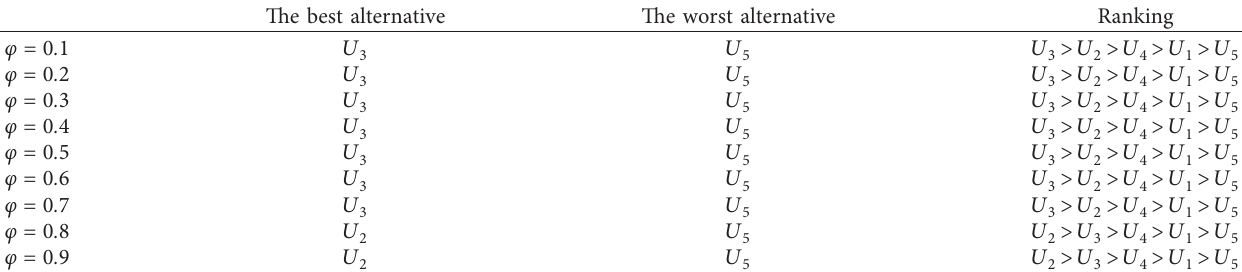
Table 11: The ranking results calculated by the improved EDAS method with different parameter values of φ . The best alternative The worst alternative Ranking